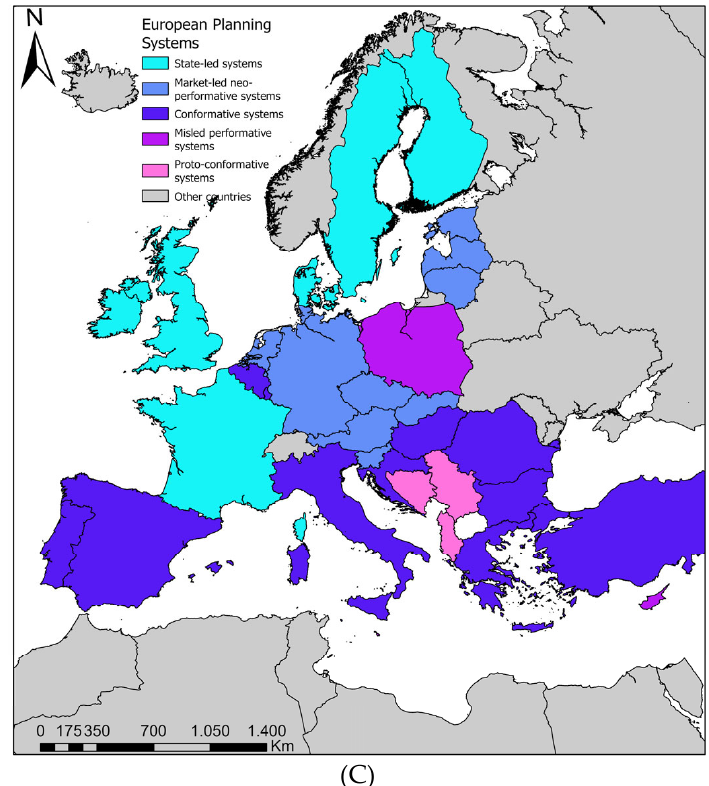
Figure 3. Spatial governance and planning systems in European countries based on Berisha et al. [60]; ( A ): Market ‐ led vs. state ‐ led development; ( B ): Conformative vs. performative systems; ( C ): European planning systems. Source: Figures were created by the authors based on the data given by Berisha et al. [60].